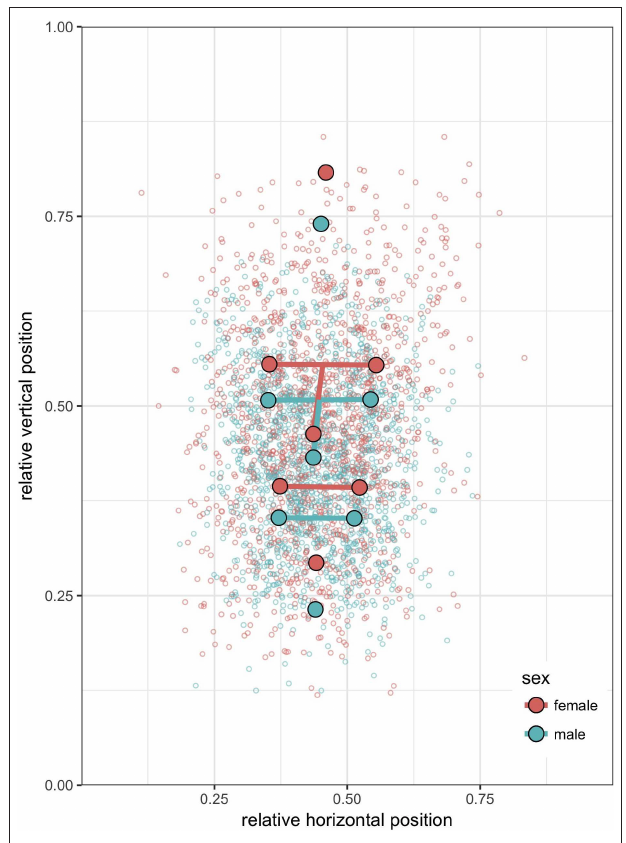
FIGURE 5 | Relative positions of seven features as they appeared in the selfies we collected: the top center of the head, the left and right eyes, the tip of the nose, the left and right corners of the mouth, and the chin. The large solid disks represent grand averages, whereas each small open circle represents one datapoint from one selfie of one observer. All data are color coded to separate male (pale blue) from female selfies (pinkish red). Segments added to highlight the face pattern. Aspect ratio of the plot adjusted to mimic the smartphone preview